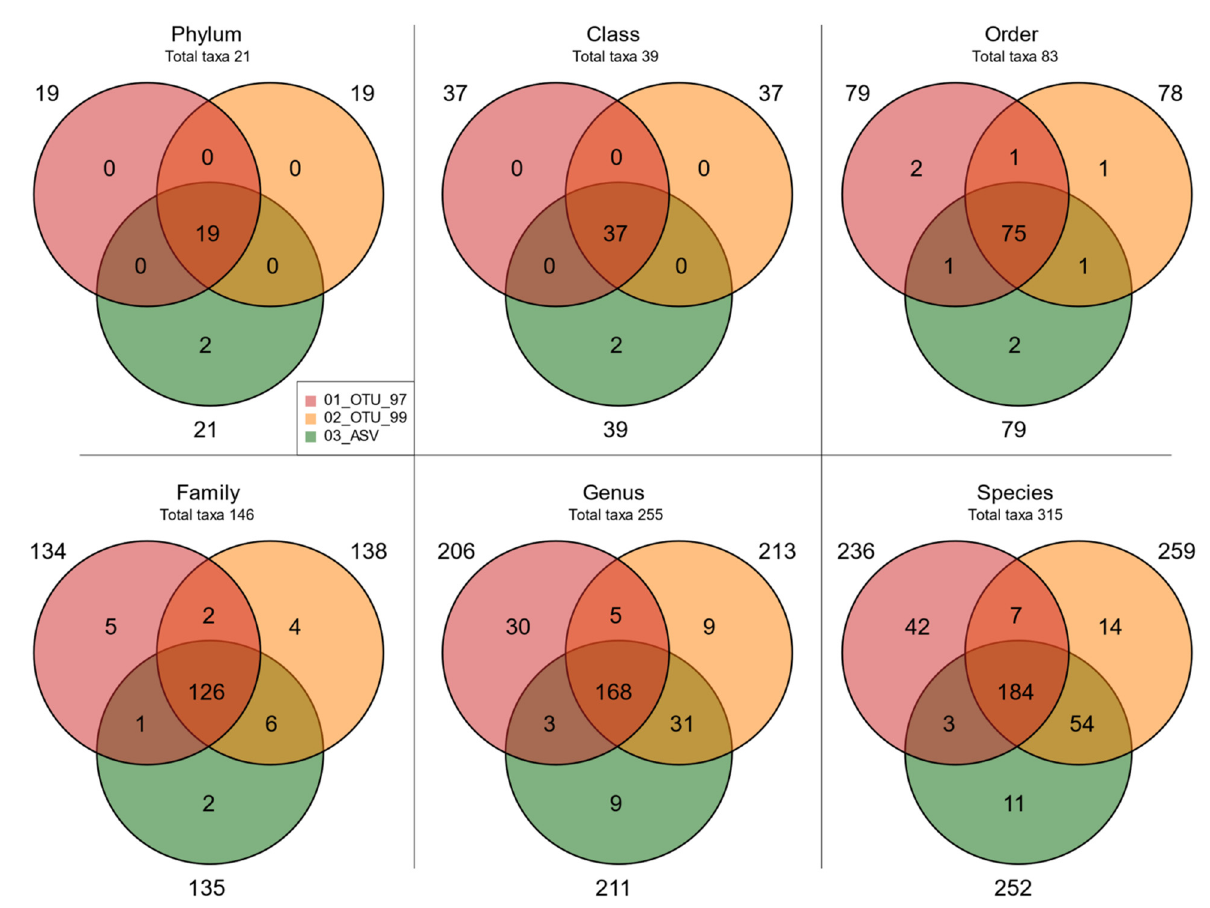
Figure 5. Taxa overlap in different sets. Venn diagrams of shared and unique taxa in the sets at different taxonomic levels. The total taxa per level are shown below the taxonomy label.